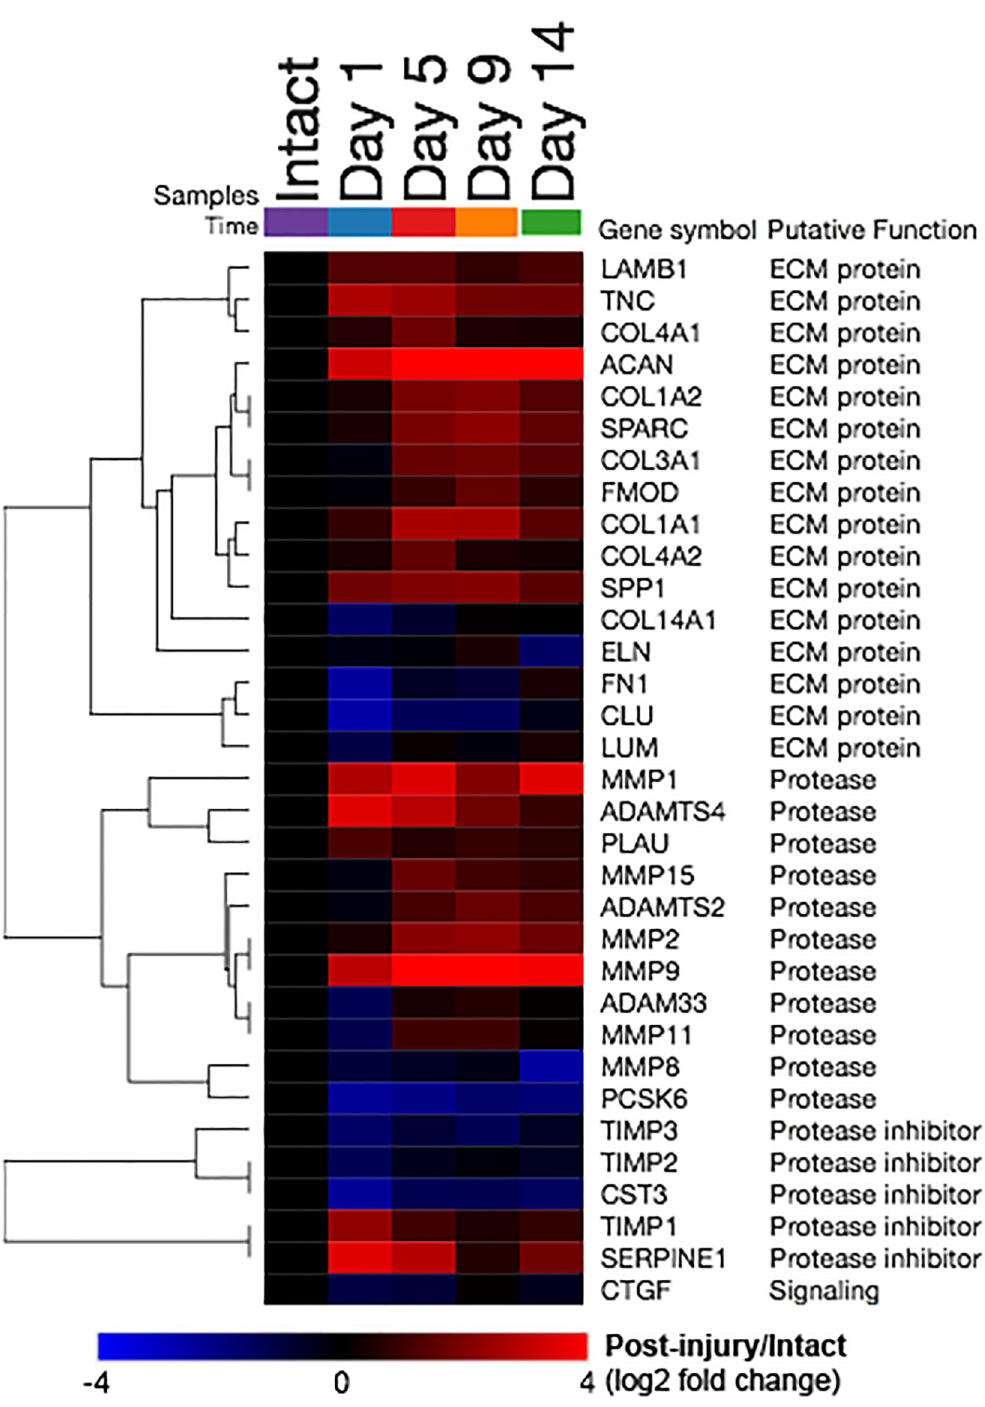
PLOS ONE | https://doi.org/10.1371/journal.pone.0229449 February 27,